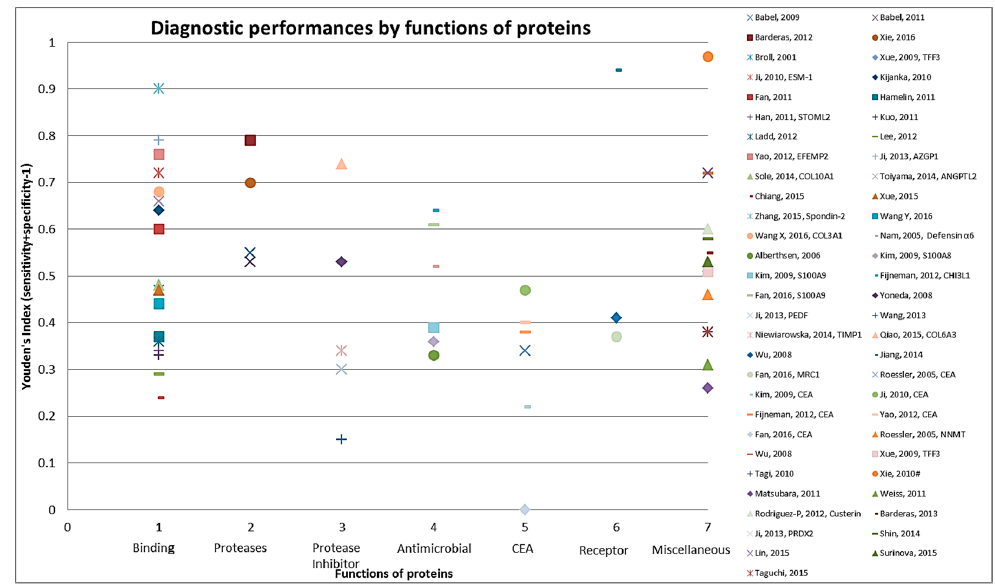
Figure 3. Graphical representation of diagnostic performance of protein markers with respect to molecular function of these protein markers.